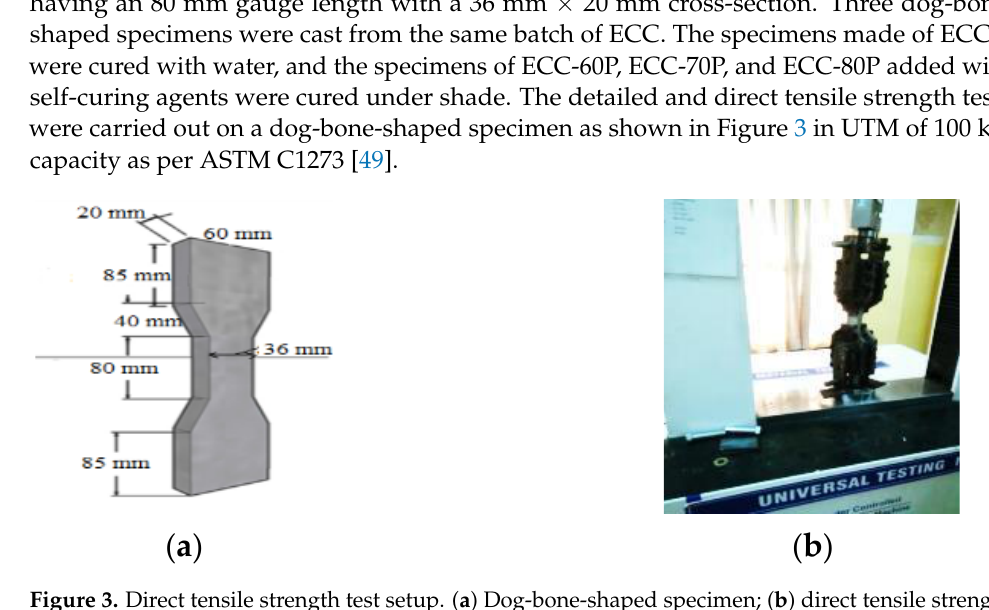
Figure 3. Direct tensile strength test setup. ( a ) Dog-bone-shaped specimen; ( b ) direct tensile strength test setup on ECC .